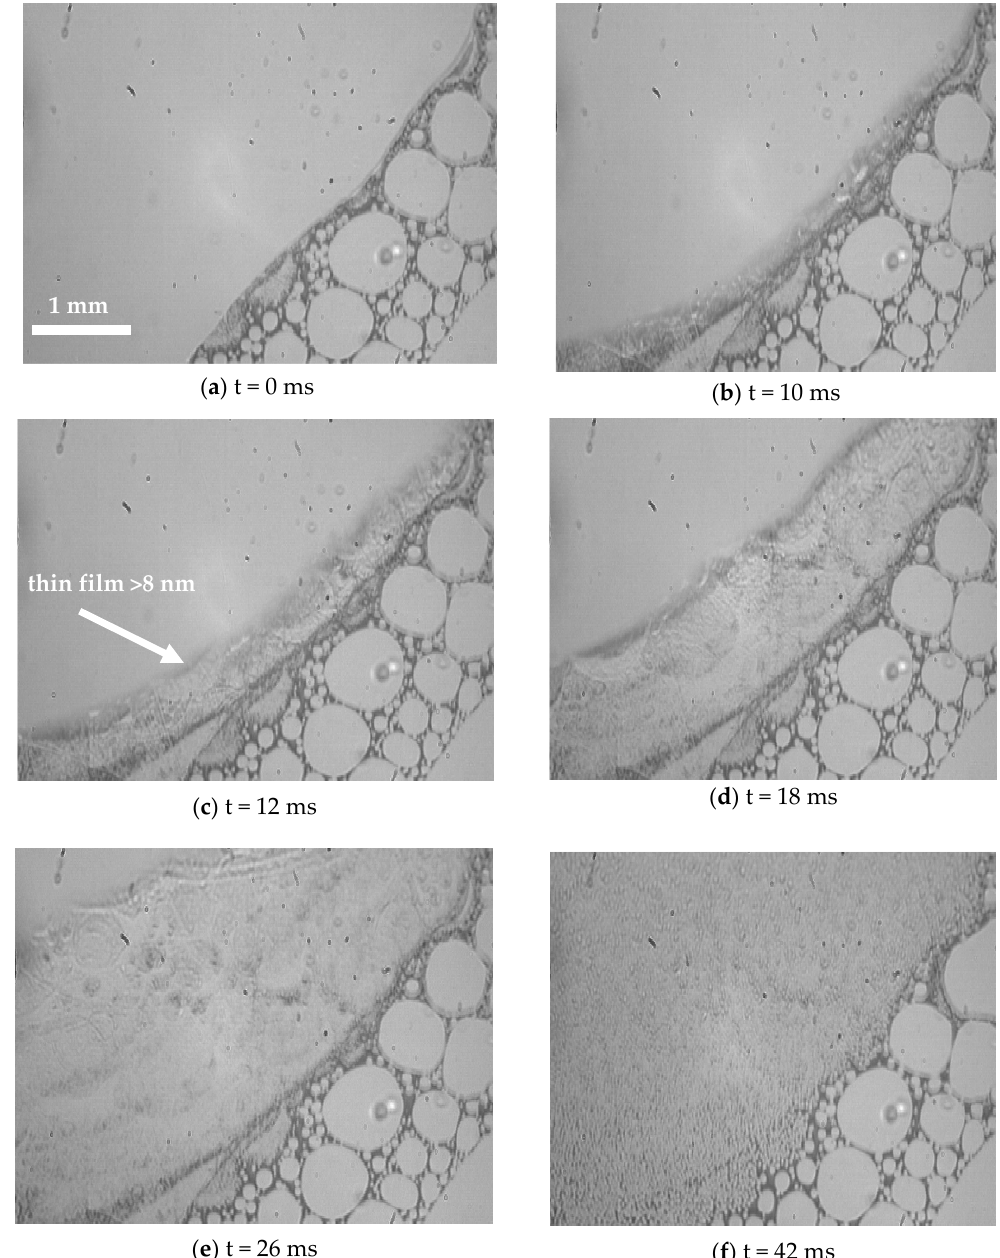
Figure 8. Selected time-lapse images of coalescence during Stage III of USDC show the presence of a thin film (>8 nm) at the exposed area and the subsequent film rupture.